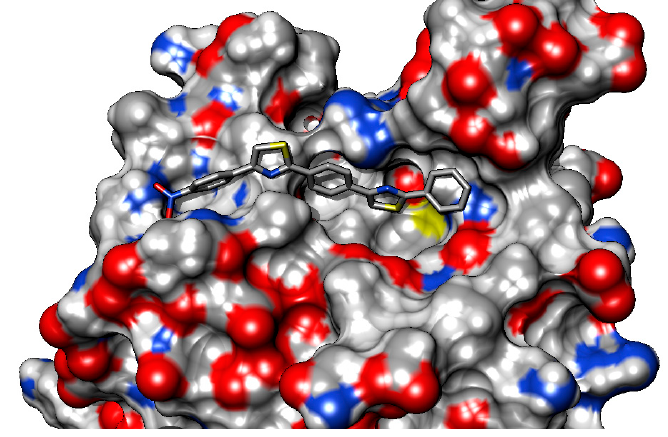
Figure 8. 3D-surface representation of the predicted binding mode of C1 – 8 to the active site of S. aureus Sortase A (PDB 1IJA). The small active site pocket does not seem able to accommodate the pentacyclic compounds.